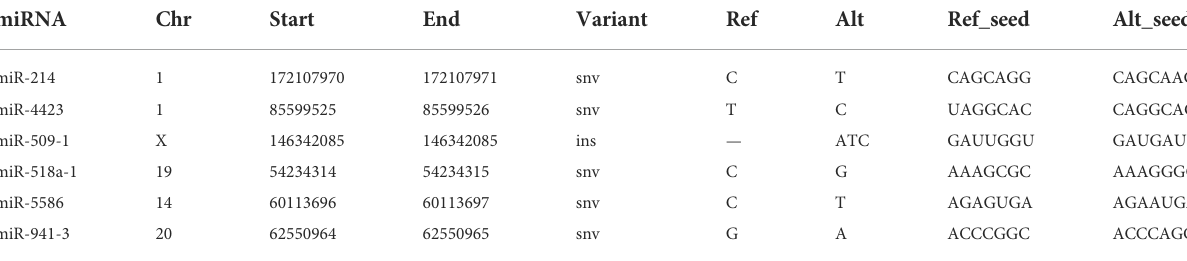
TABLE 4 List of miRNAs with rare variants in the seed sequence.